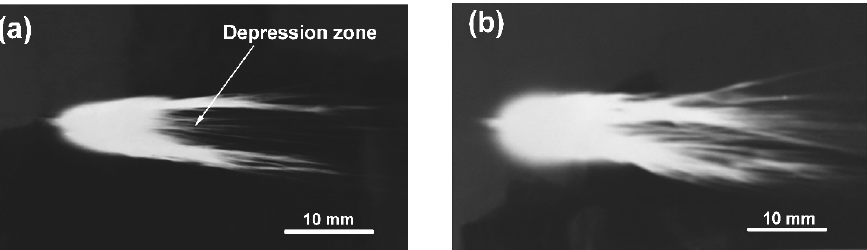
Figure 5. The metal particles stream being atomized in the arc discharge: ( а ) the “top view”, ( b ) the “side view”.